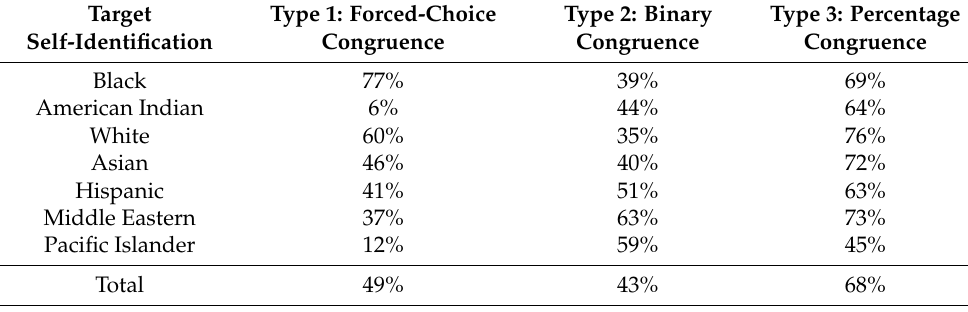
Table 3. Mean percent congruent, by racial identification of target.